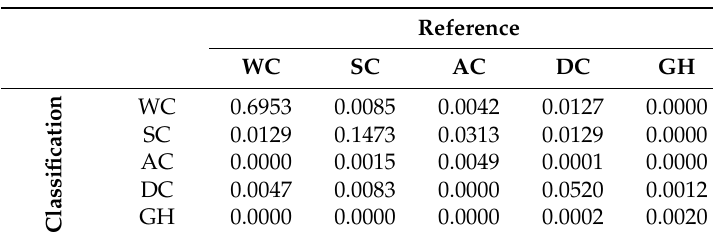
Table A3. Confusion matrix for variable subset “WKL_TC”. Cells populated with adjusted probabilities [54]. WC: winter cropping, SC: summer cropping, AC: semi-aquatic cropping, DC: double-cropping, GH: greenhouse cultivation.